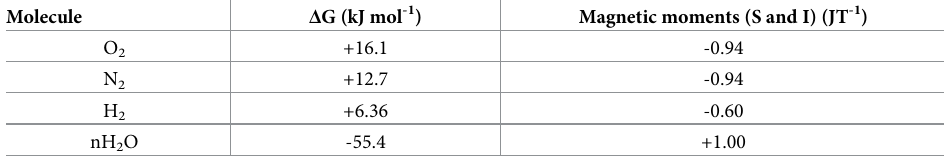
Table 3. Gibbs energy ( Δ G) and magnetic moments for dissolved gases.